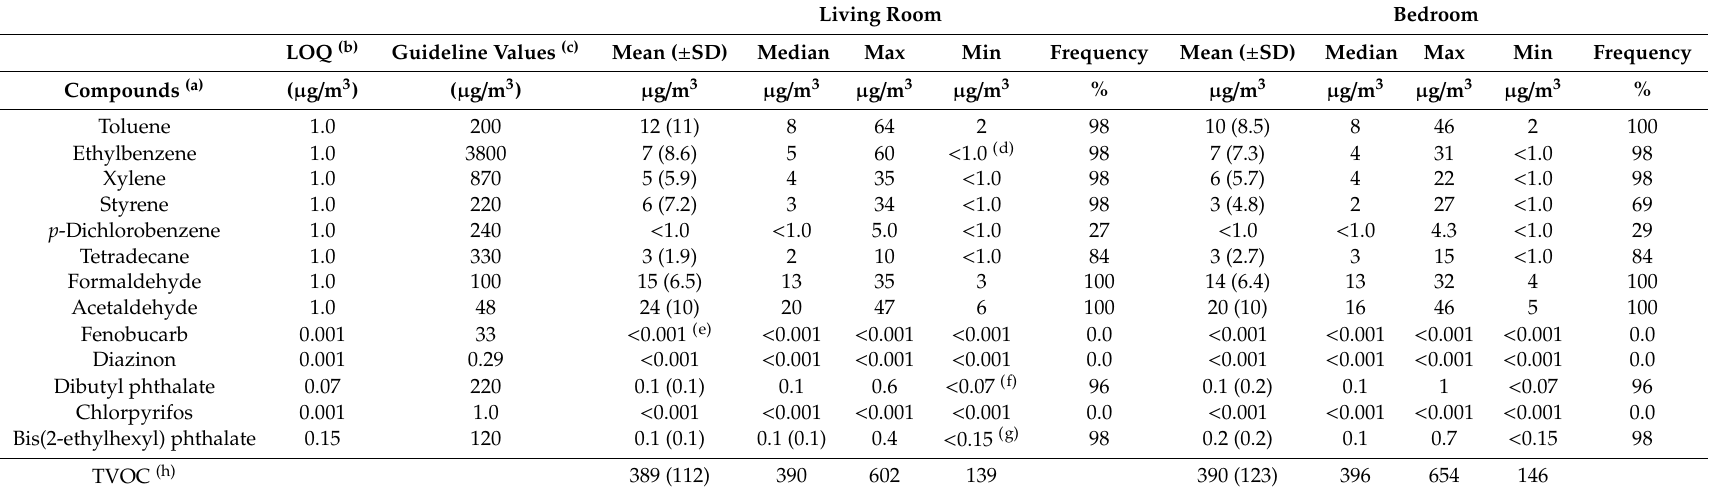
Table 2. Concentrations and frequencies of 13 regulated compounds and the TVOC, including a comparison with the maximum values recommended by the MHLW of